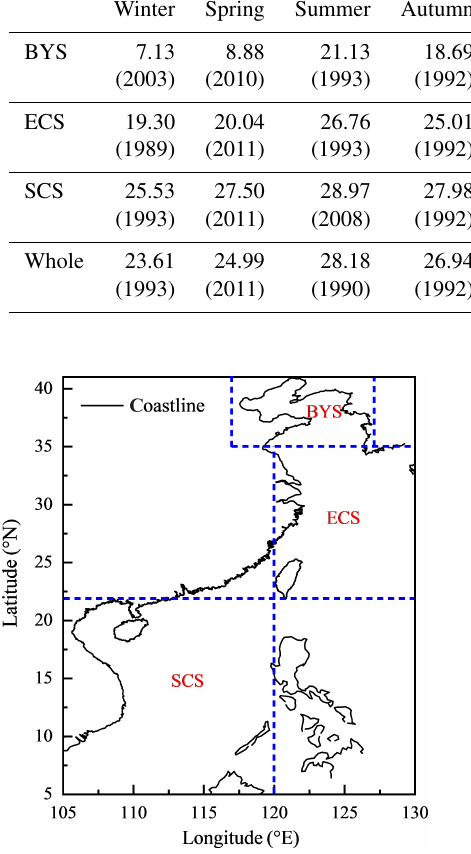
Table 3. Peak value and time of the annual and seasonal SST of the study area in China offshore based on monthly data from 1988 to 2017. Minimum ( ◦ C) and time (year)